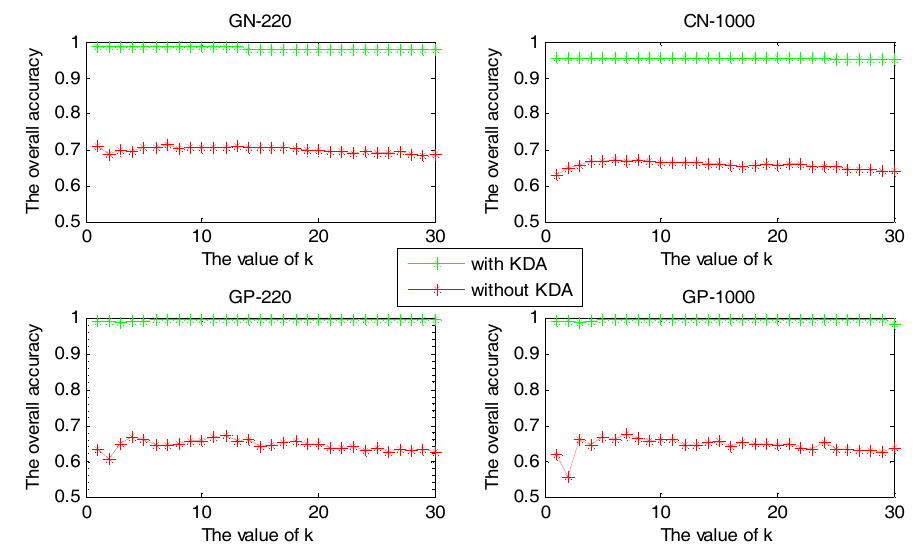
Figure 3. The overall accuracy versus k value with or without KDA algorithm.